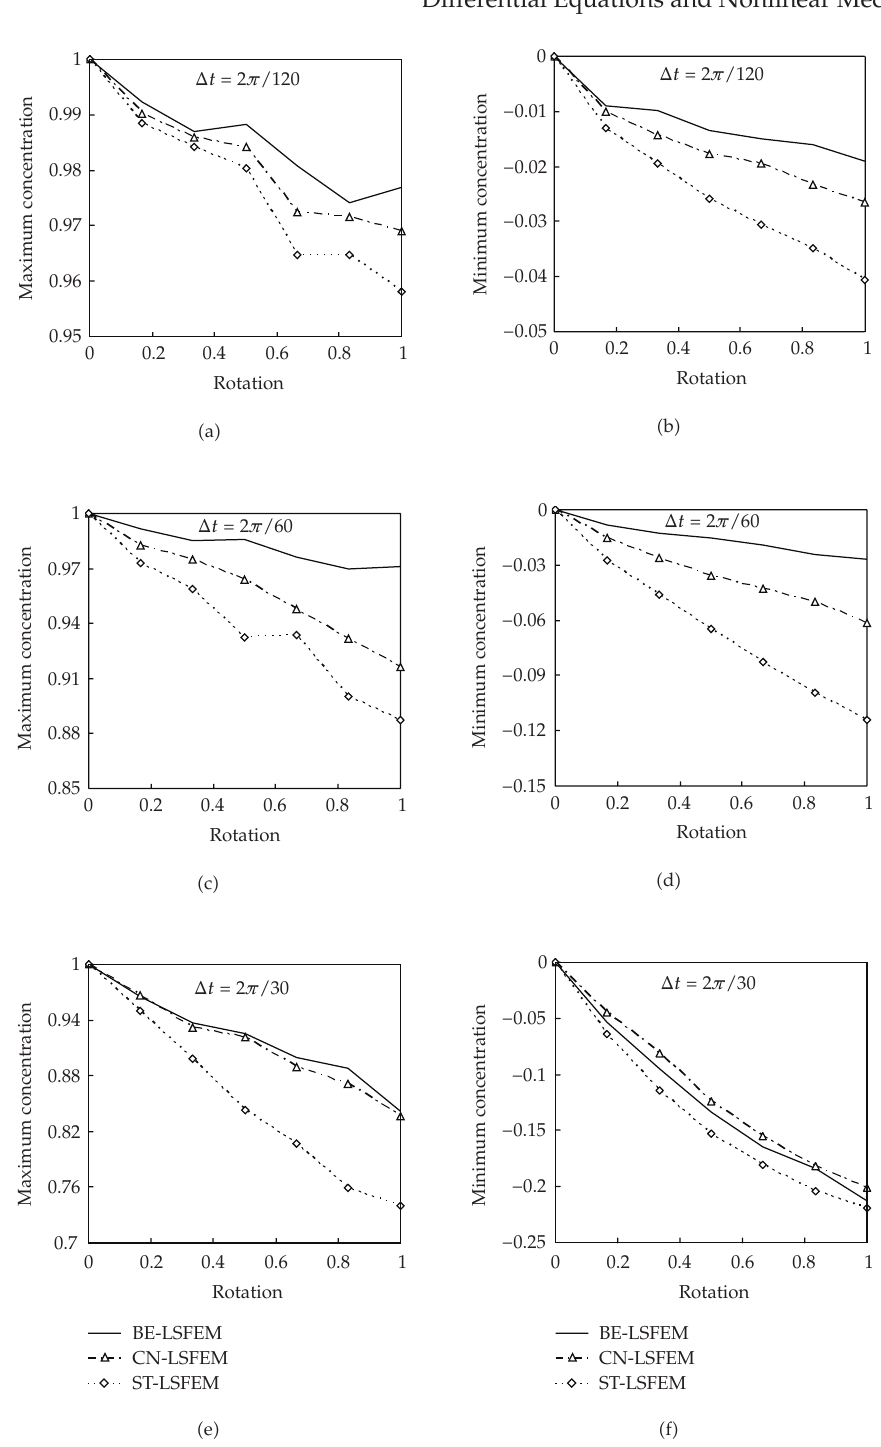
Figure 6: Variation of maximum and minimum concentrations with time for advection of cosine hill in rotation : comparison of results over one